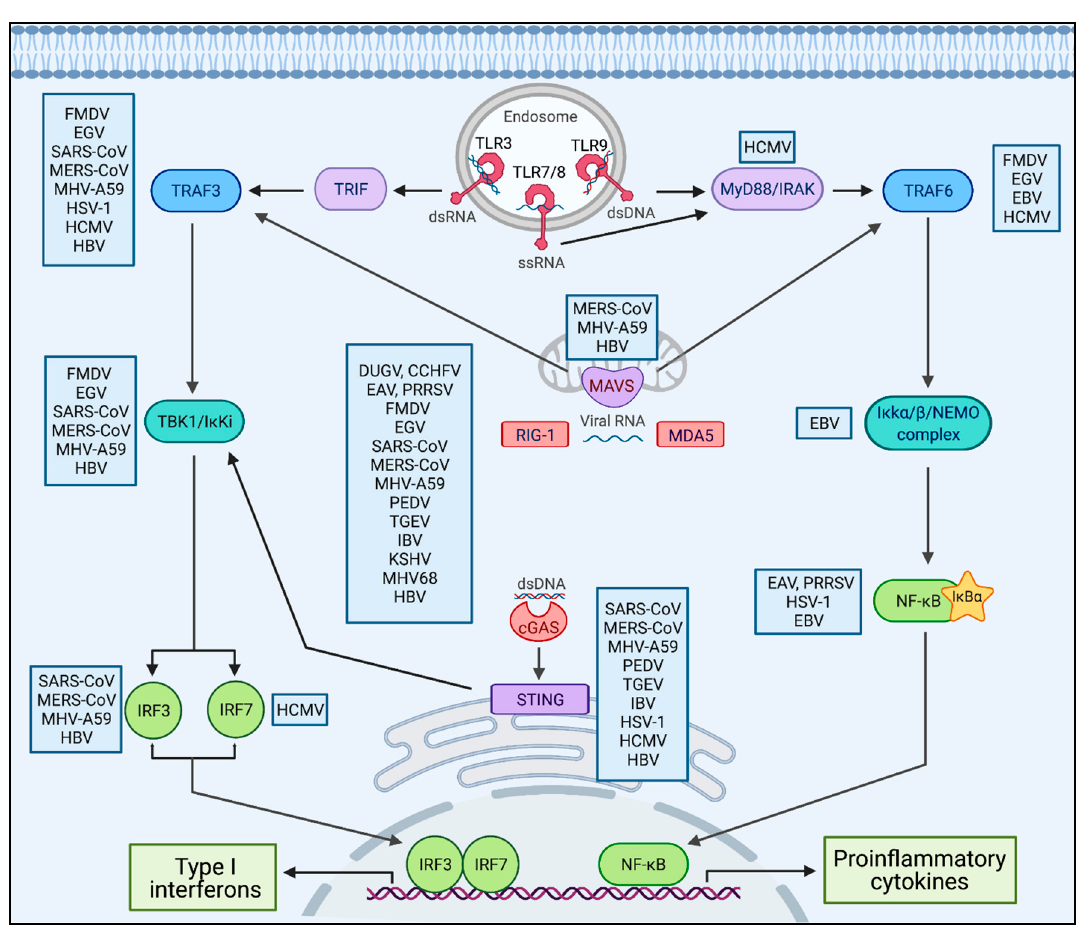
Figure 2 . Viruses block innate immune signaling pathways using DUB activity. Viral recognition (red) initiates a cascade of signaling mediators (purple/blue/turquoise) leading to the activation of transcription factors (green) to induce expression of proinflammatory cytokines and type I interferons (green boxes). Viruses (blue boxes) exploit virally encoded DUBs to block different steps within innate immune signaling pathways. Image made with BioRender.com.